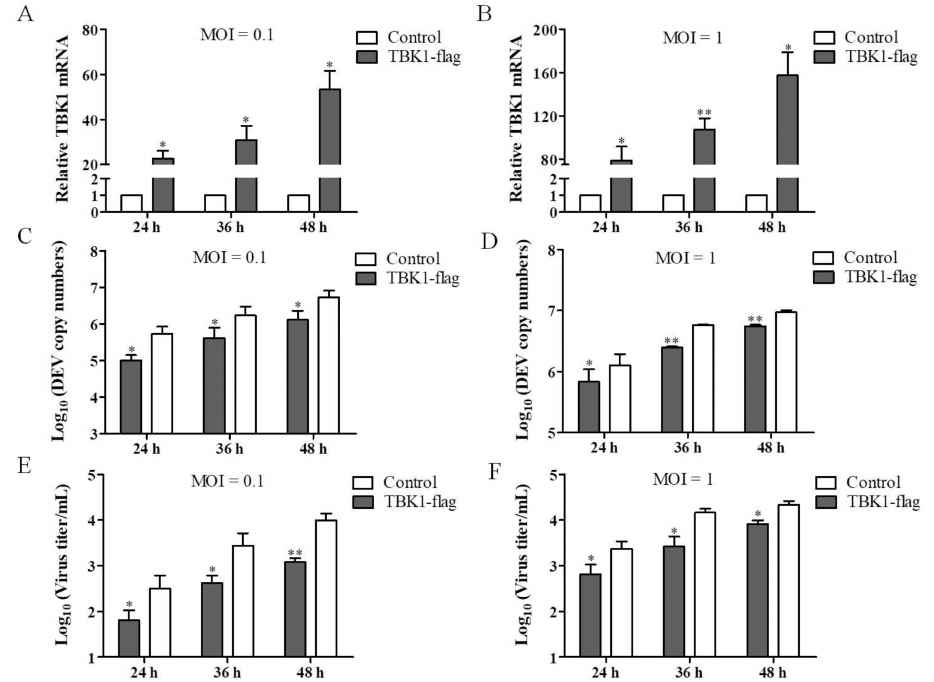
Figure 3. Overexpression of TBK1 inhibits DEV infection. ( A – E ) DEF cells were transfected with pCAGGS-TBK1 and infected with DEV at a MOI of 0.1 or 1, for 24 h, 36 h, 48 h, respectively. ( A ) The qRT-PCR results of TBK1 expression at a MOI of 0.1. ( B ) The qRT-PCR results of TBK1 expression at a MOI of 1. ( C ) DEV copy number determined by qRT-PCR at a MOI of 0.1. ( D ) DEV copy number determined by qRT-PCR at a MOI of 1. ( E ) DEV titer in the TCID 50 assay titer at a MOI of 0.1. ( F ) DEV titer in the TCID 50 assay titer at a MOI of 1. Mean ± SD of three technical replicates are shown. * p < 0.05, ** p < 0.01.